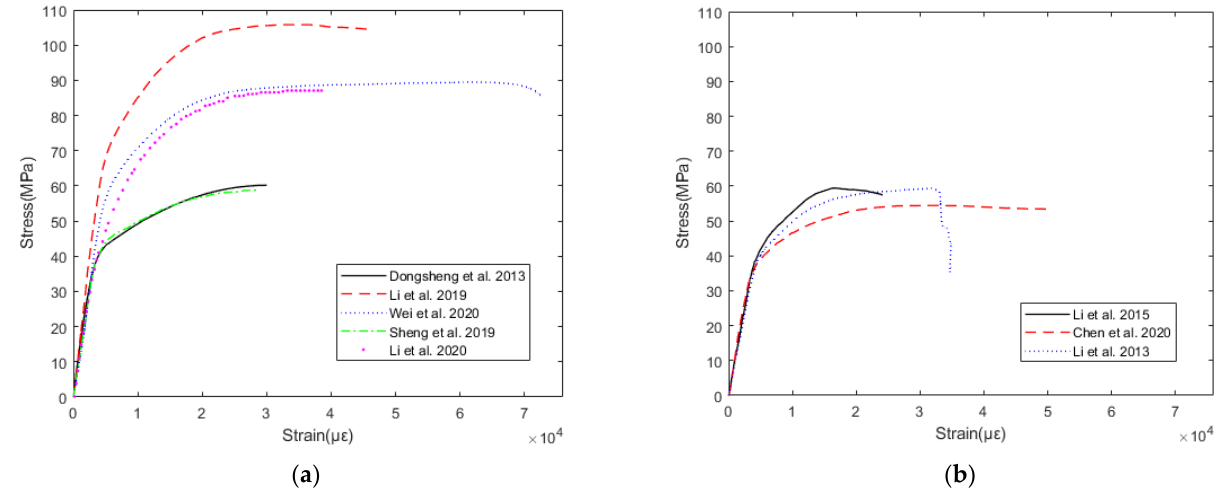
Figure 2. Compressive stress-strain curves for ( a ) bamboo scrimber [19,45 – 48]; ( b ) LBL [18,34,39].